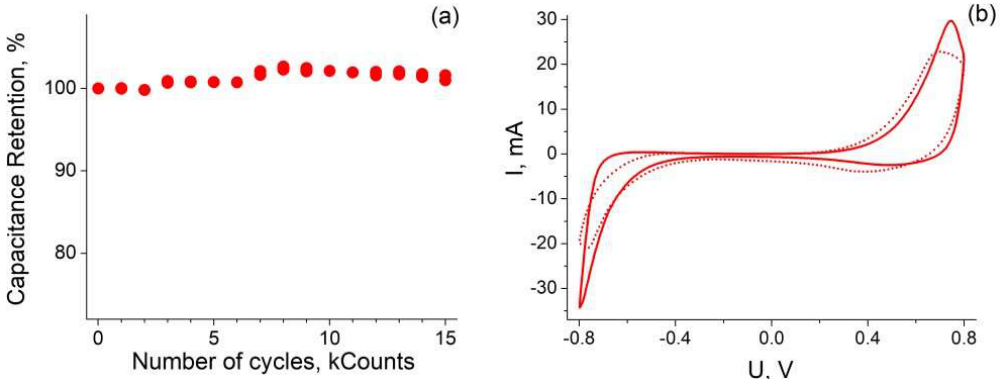
Figure 5. Dependence of capacity retention of graphene-coated 80 μm thick sample in 3М H 2 SO 4 from number of cycles ( a ). CV curves for the same sample at 100 mV/s scan rates before (solid curve) and after (dotted curve) cycling ( b ).